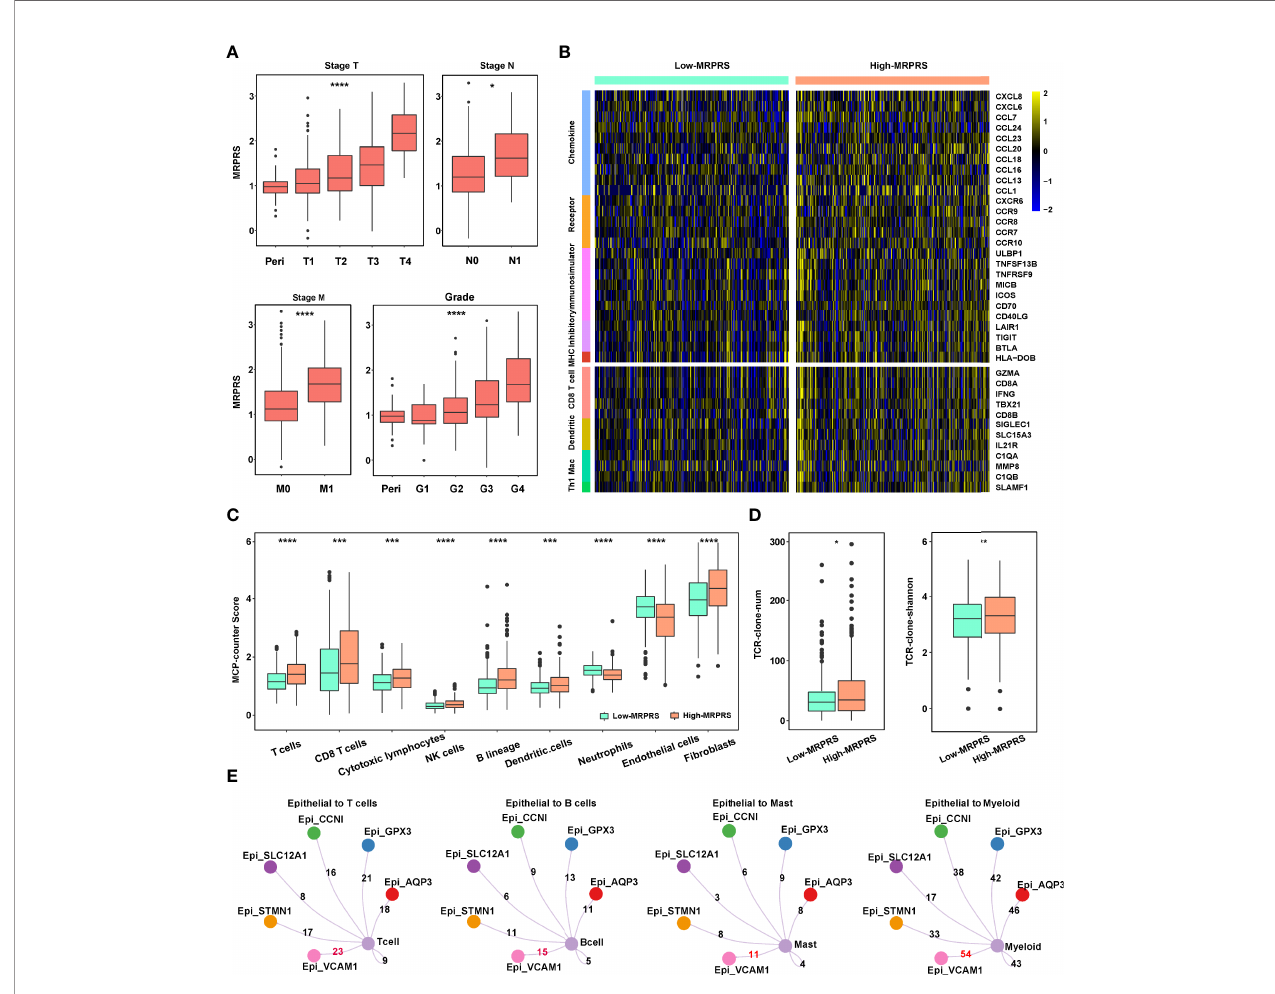
FIGURE 3 | (A) Box plot of the relationship between stage T, N, M, grade, and MRPRS. (B) The heatmap of markers on multiple immune in fi ltrates. (C) The MCP_counter algorithm was used to estimate the abundance of various types of immune cells between high- and low-MRPRS groups. (D) The abundance and diversity of TCR clone in high- and low-MRPRS groups. (E) Crosstalk between immune cells and epithelial cells (*p < 0.05; **p < 0.01; ***p < 0.001; ****p <